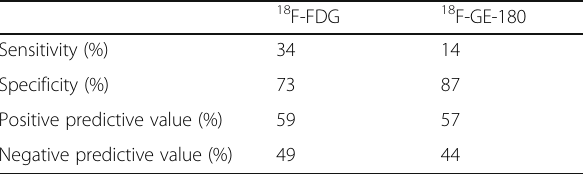
Table 4 PET-CT visual score and clinical status, performance at identifying symptomatic joints